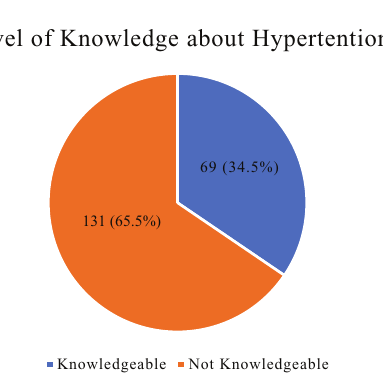
Figure 1. Overall level of lifestyle modification practices and level of knowledge about hypertension and associated factors among hypertensive patients.